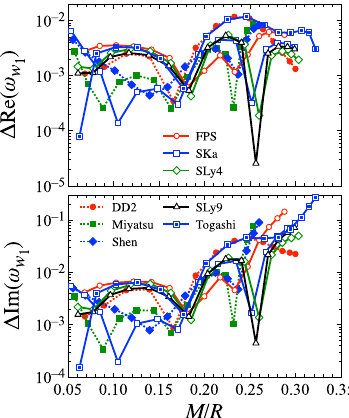
Fig. 8 The relative deviation of the value of ω r determined with the one-dimensionalapproximationfromthatofRe (ω) determinedthrough the proper eigenvalue problem is shown as a function of stellar com- pactness for various neutron star models in the top panel. In the bottom panel, we show the relative deviation of the imaginary part of the eigen- value estimated with the one-dimensional approximation from that of Im (ω) determined through the proper eigenvalue problem, calculated with Eq.